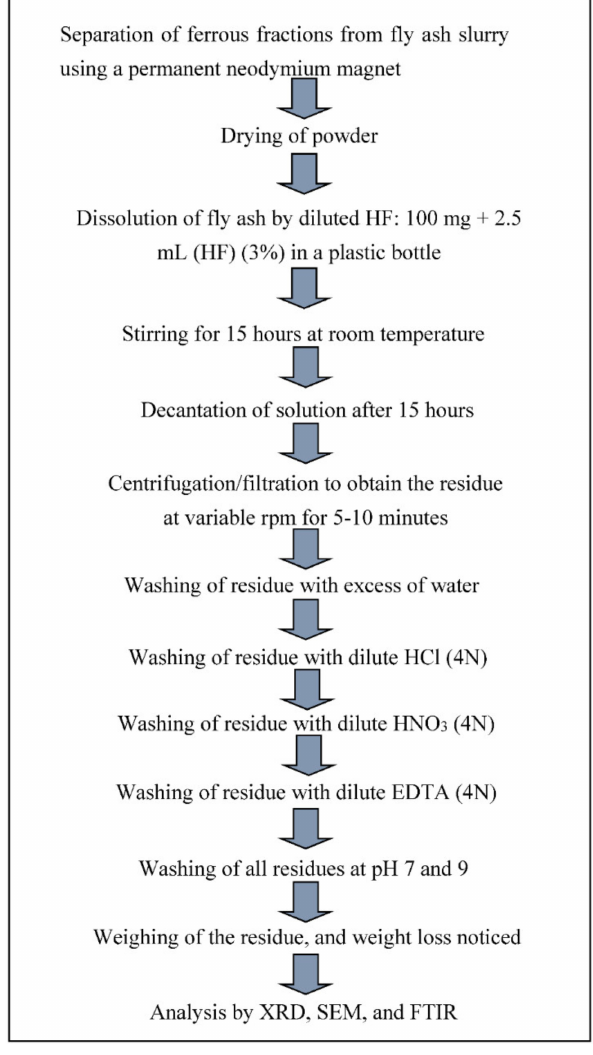
Figure 3. Schematic diagram for the recovery of mullite from CFA adopted from Yadav et al., open access journal Crystals, 2021